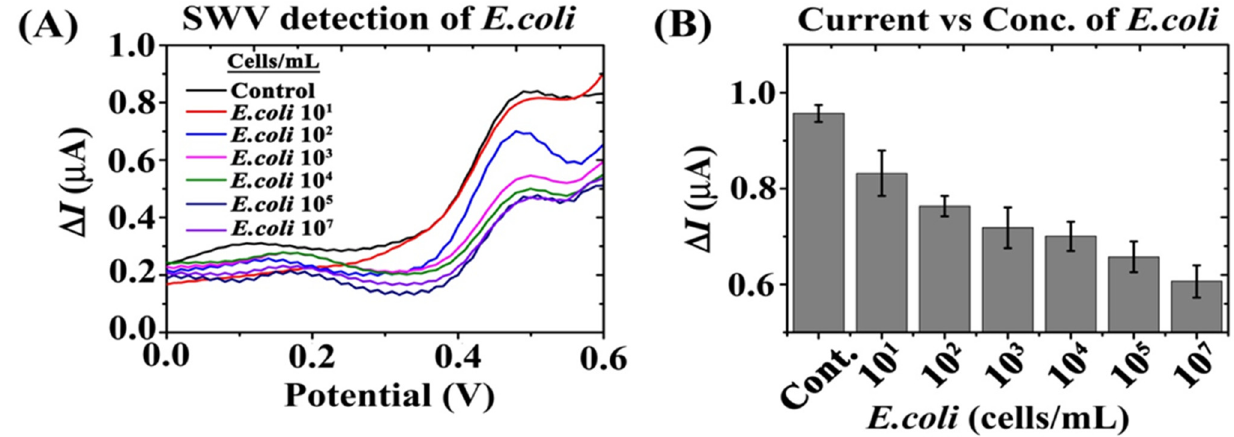
Figure 7. Electrochemical detection of different concentrations of E. coli cells using bi-functional MNPs conjugate (Fc-MNP-IgG) under magnetic field. ( A ) SW voltammogram of Fc-MNP-IgG with different concentrations E. coli (0, 10 1 , 10 2 , 10 3 , 10 4 , 10 5 , and 10 7 cells/mL). ( B ) Bar graph represents the measured peak currents ( ∆ I) of Fc-MNP-IgG at different concentrations of E. coli cells. Error bars indicate the standard error of the means. SWV parameters: amplitude 0.1 V; scan increment 0.01 V; frequency 20 Hz and duration 4 s.